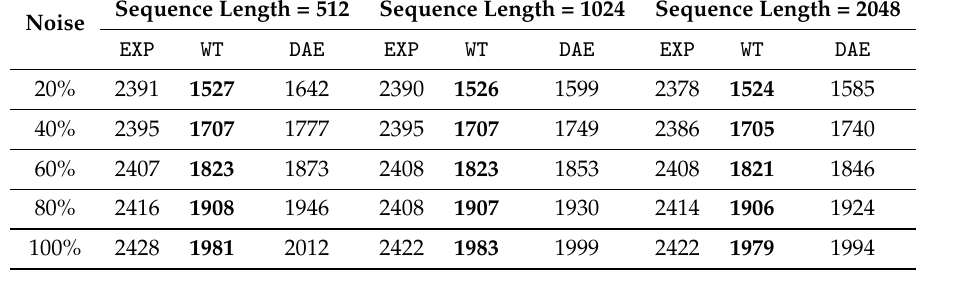
Table 3. Filtering accuracy on voltage data of different sequence lengths. The boldface numbers denote the best value in each experiment.